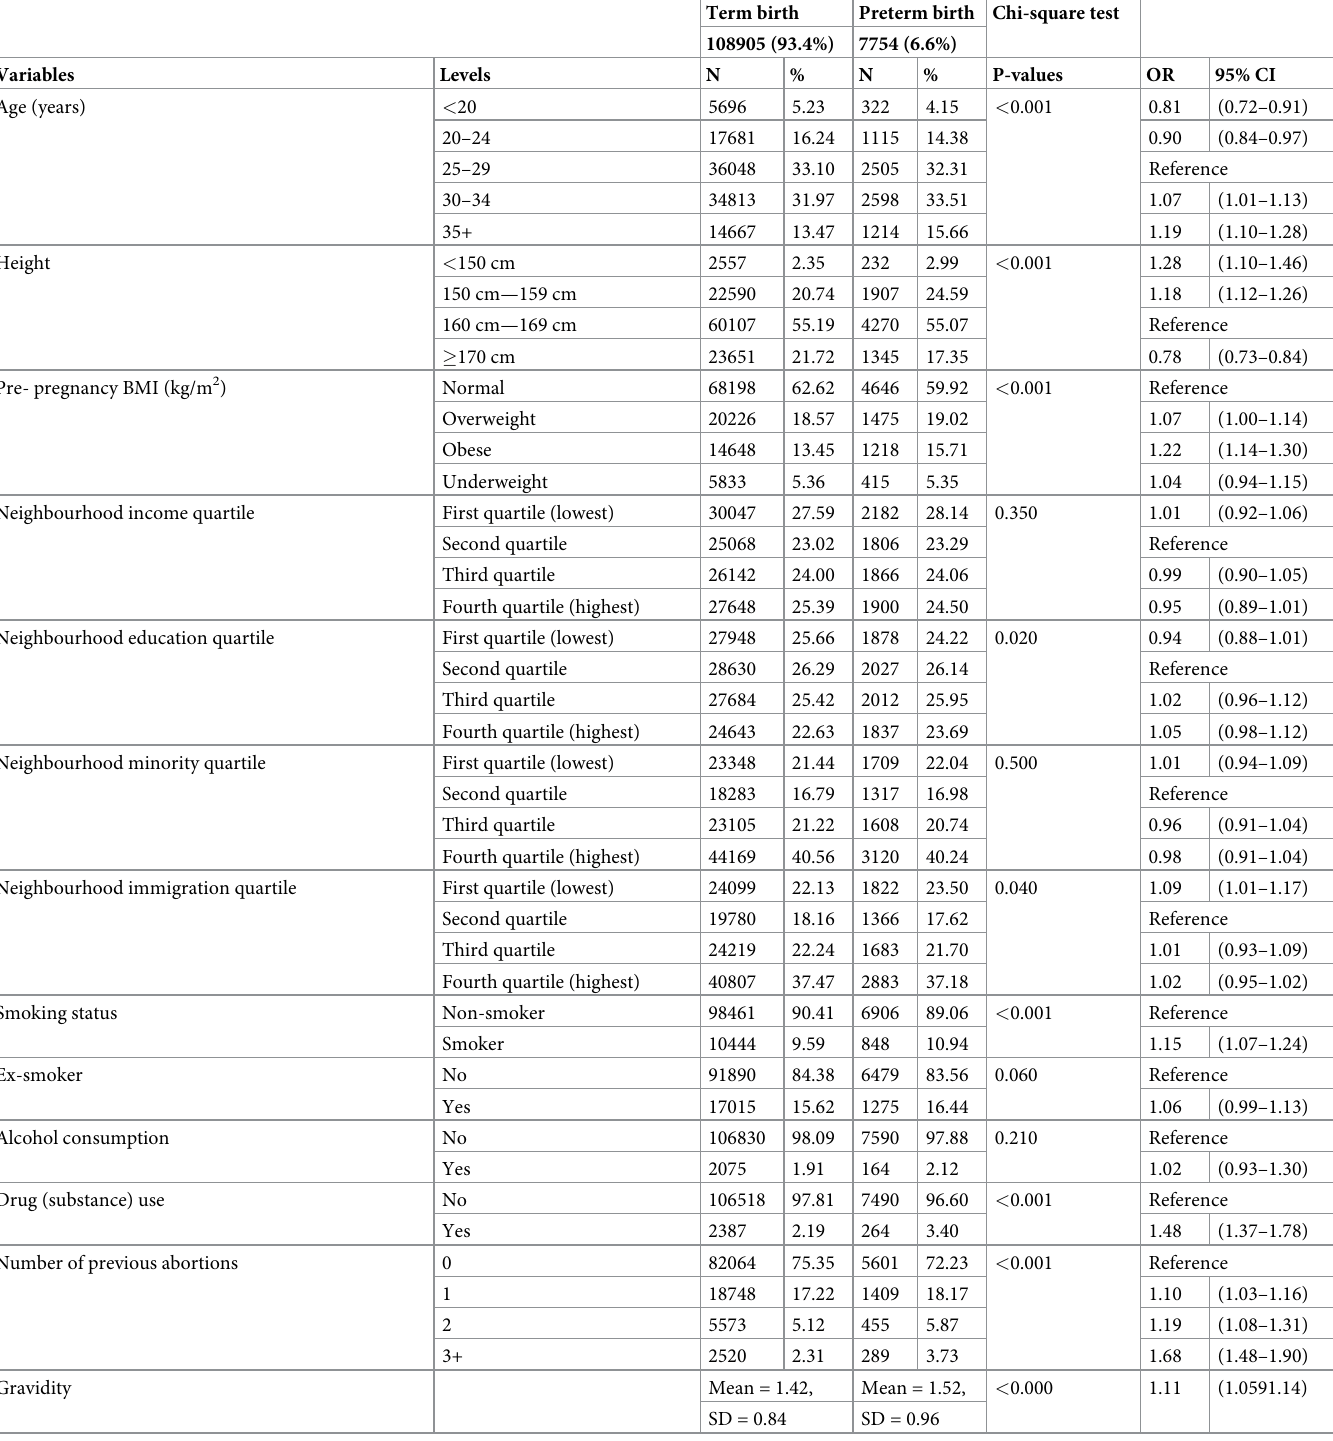
Table 3. Univariate analyses of associations between each predictor and preterm birth during the second trimester in nulliparous